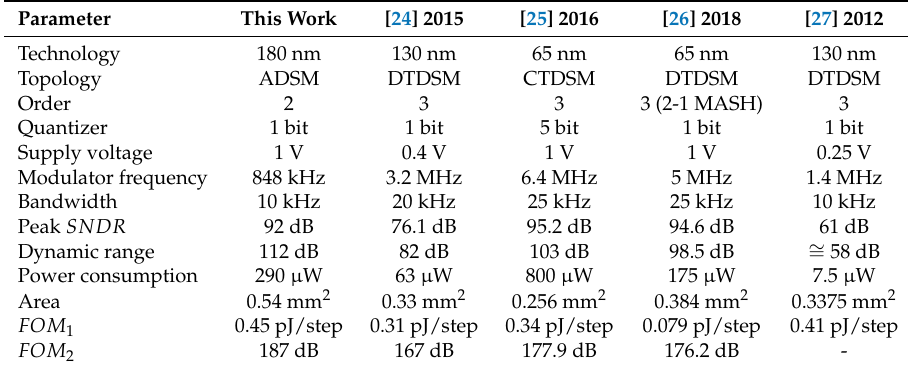
Table 4. Specifications of the proposed ADSM in comparison with other